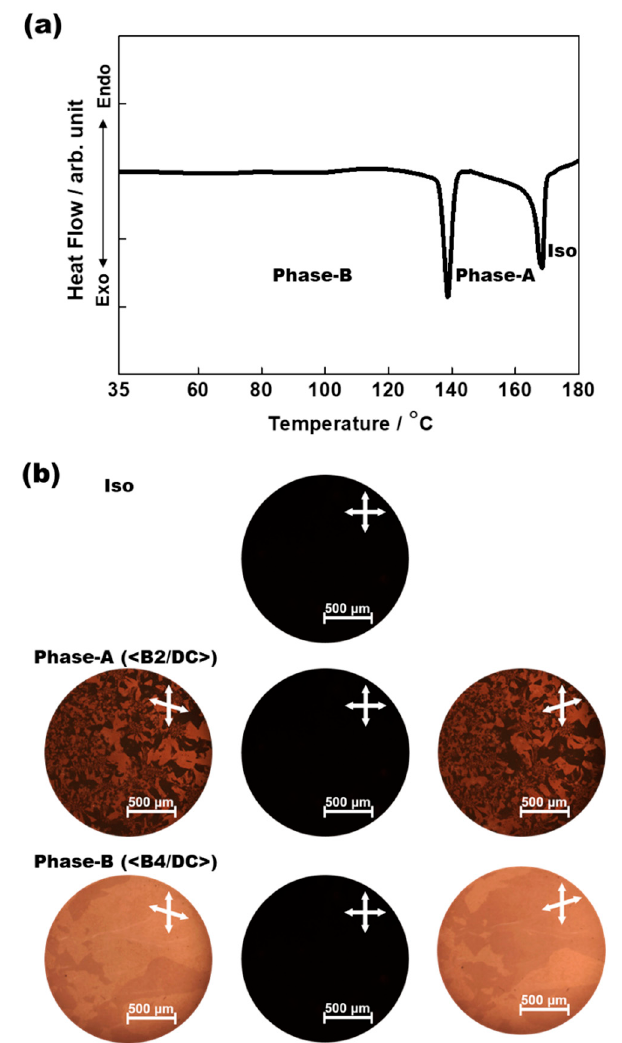
Figure 2. ( a ) Typical DSC profile obtained during the cooling of a binary mixture consisting of 70 wt% BC molecule and 30 wt% BCMP. ( b ) Typical POM images of Iso, Phase-A, and Phase-B. XRD measurements were performed to elucidate the local structures of Phase-A and Phase-B. Figure 3a shows a typical XRD profile in the temperature range of Phase-A for a small-angle region, and the XRD profiles of pure B2 (originating from the BC molecule) and pure DC (originating from the BCMP). In the pure B2 phase, three distinct diffraction peaks were detected (at 1.3, 2.6, and 3.9 nm − 1 ), while in the pure DC phase, two distinct peaks were observed (at 1.45 and 4.37 nm − 1 ). As shown in Figure 3a, the XRD profile for Phase-A could be considered to be a simple superposition of those for the pure B2 and DC phases. Thus, Phase-A segregated the <B2/DC> nanophase, whereas the BC and BCMP were in the B2 and DC phases, respectively. Figure 3b exhibits a typical XRD profile in the temperature range of Phase-B for a small-angle region along with the XRD profiles of pure HNF B4 (originating from the BC) and pure DC (originating from the BCMP). In the pure B4 phase, three distinct diffraction peaks were observed (at 1.6, 3.2, and 4.8 nm − 1 ). The XRD pattern of Phase-B also appeared to be a superposition of those of HNF B4 (BC) and DC (BCMP). Thus, Phase-B segregated the <B4/DC> nanophase, in which the BC and BCMP were in the HNF B4 and DC phases, respectively. Based on the results of the above-mentioned DSC, POM, and XRD analyses, upon cooling, the binary system consisting of 70 wt% BC molecule and 30 wt% BCMP was assigned the structure Iso-168 ◦ C-<B2/DC>-140 ◦ C-<B4/DC>.